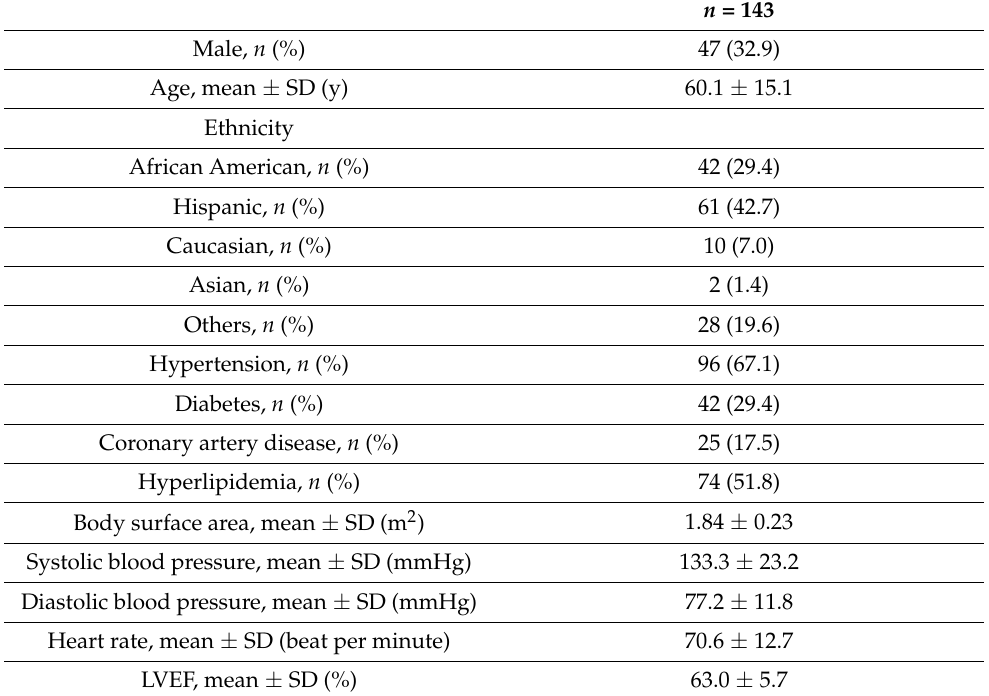
Table 1. Patient characteristics.